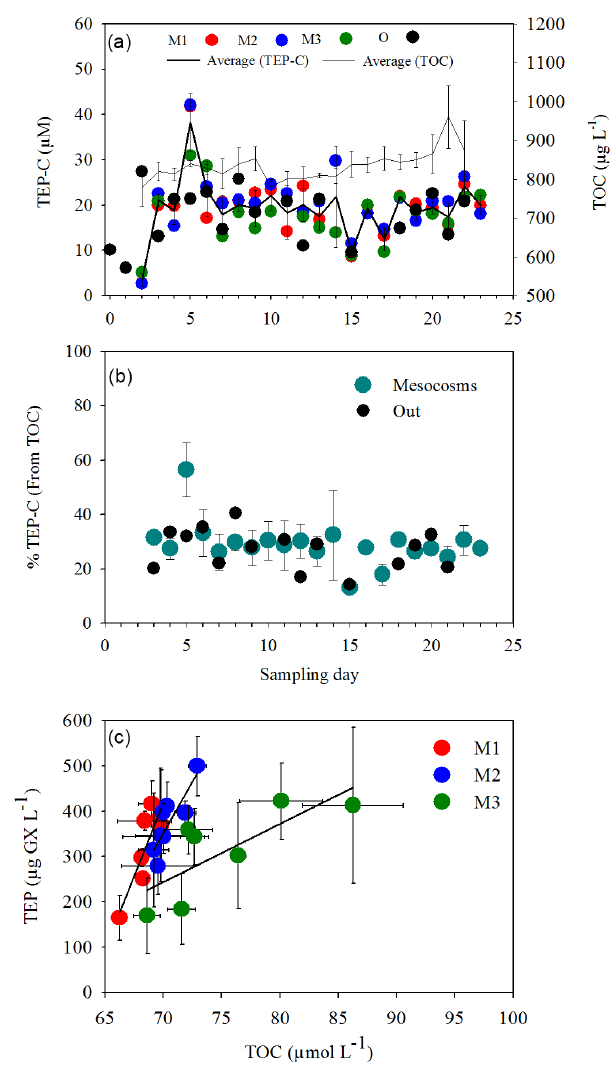
Figure 4. (a) Temporal dynamics of TEP carbon concentrations (TEP-C, µM) in relationship to the average total organic carbon (TOC) (µgL − 1 ) (thin black line) in the mesocosms (M1 – red dots, M2 – blue dots, M3 – green dots, and black dots – outside wa- ters (O). The black solid line designates TEP-C averaged for the three mesocosms (thick black line). TEP-C was measured from 6m depths and calculated according to Engel (2000). (b) Tempo- ral changes in the percentage of TEP-C in TOC (%) in mesocosms (green dots), and the percentage of TEP-C in the lagoon waters (Out), (black dots). (c) Relationship between TEP concentrations (µgGXL − 1 ) and TOC (µmoleL − 1 ), during phase 2 (days 15–23) for Mesocosm 1 (M1, red dots), Mesocosm 2 (M2, blue dots), Mesocosm 3 (M3, green dots). Significant correlations were ob- served (Pearson) for all mesocosms. R 2 = 0 . 75 – M1, 0.73 – M2, and 0.58 – M3 respectively, n = 7–8, p < 0.05. All statistics are detailed in Table S2, ( p = 0 . 05, n = 7–8). Error bars represent ± 1 standard